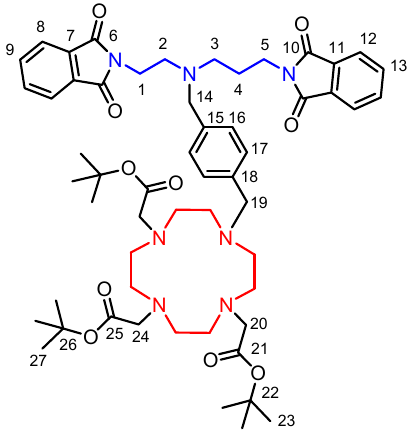
Figure 8. Schematic representation of the intermediate 3 , together with the atom numbering used for the interpretation of NMR spectra of all intermediates as well as the final product 5